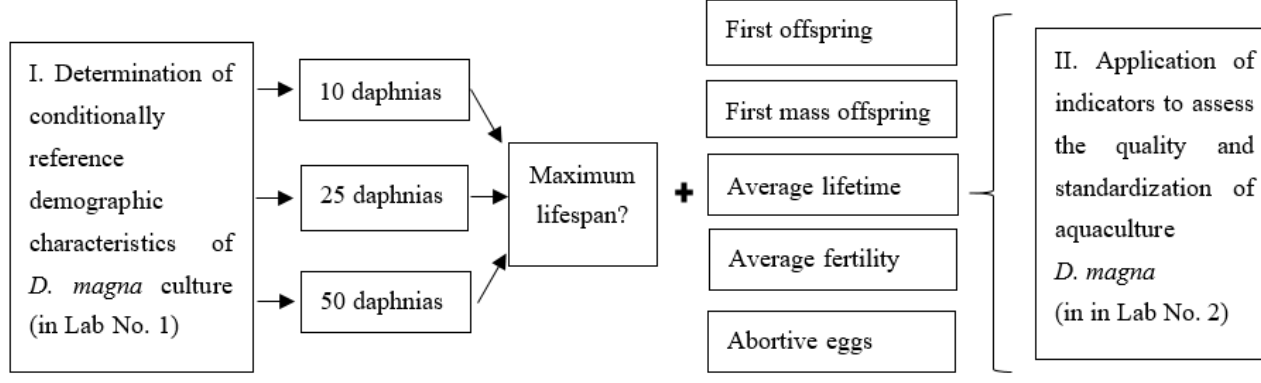
Figure 1. Research Figure 1. Research design.